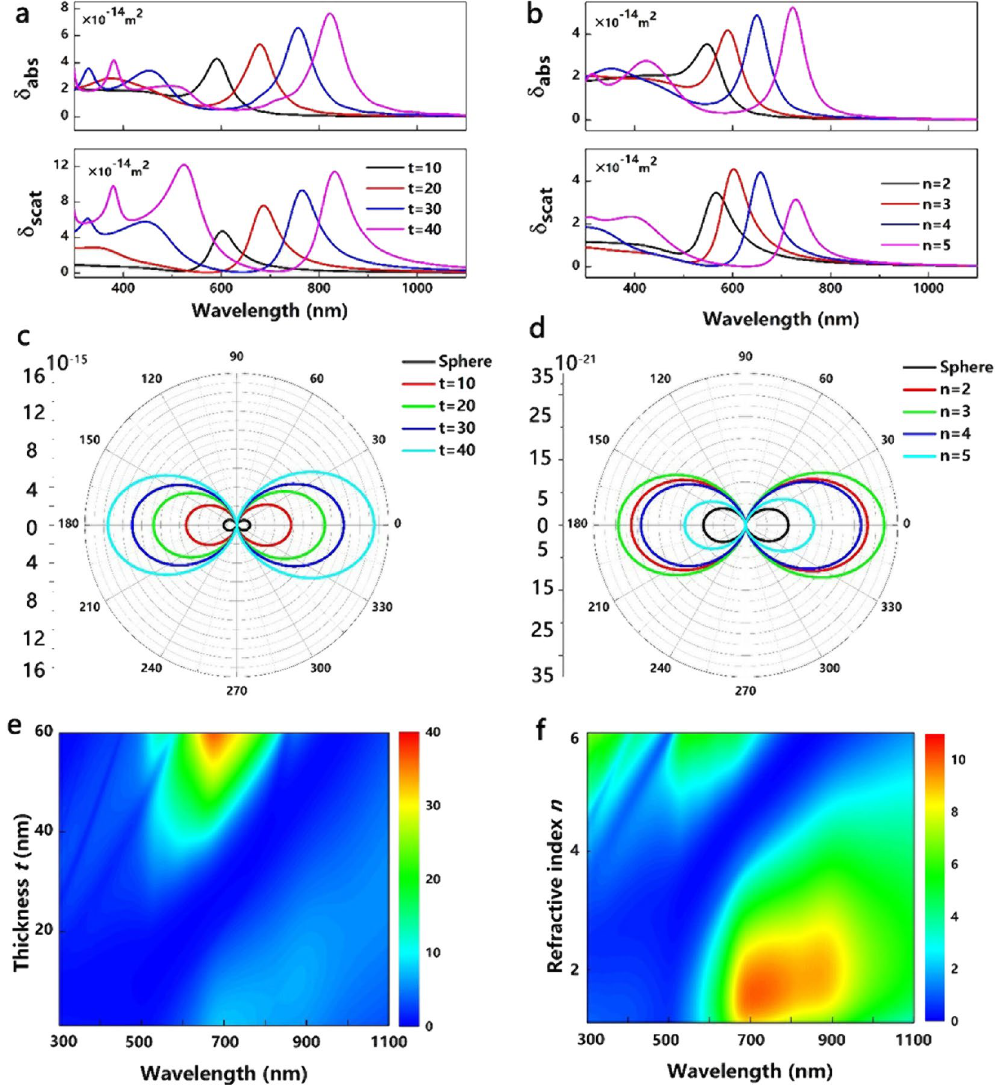
Figure 3. Scattering cross section and absorption cross section of a 100 nm Au nanosphere with ( a ) Coating thickness t = 10, 20, 30, 40 nm. ( b ) With refractive index of coating dielectric n = 2, 3, 4, 5. Angular scattering (a. u.) of ( c ) a 100 nm Au nanosphere with coating thickness t = 10, 20, 30, 40 nm. The refractive index of coating dielectric index n is set as 3. ( d ) 100 nm Au nanosphere with n = 2, 3, 4, 5; t = 10 nm. The Y-axis value is square of the scattering intensity. Calculated scattering-to-absorption cross section ( S ) as ( e ) the function of t with n = 3.4 and a 120 nm Au core. ( f ) As the function of n with t = 15 nm and a 120 nm Au